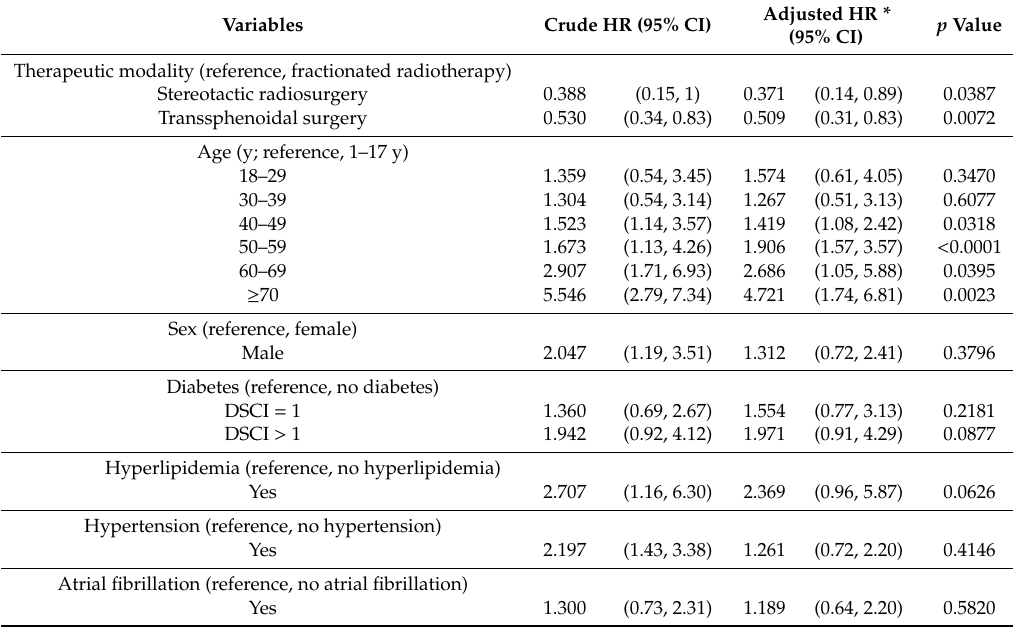
Table 6. Cox proportional hazards regression analysis of stroke risk in patients with nonfunctioning pituitary macroadenomas who received di ff erent